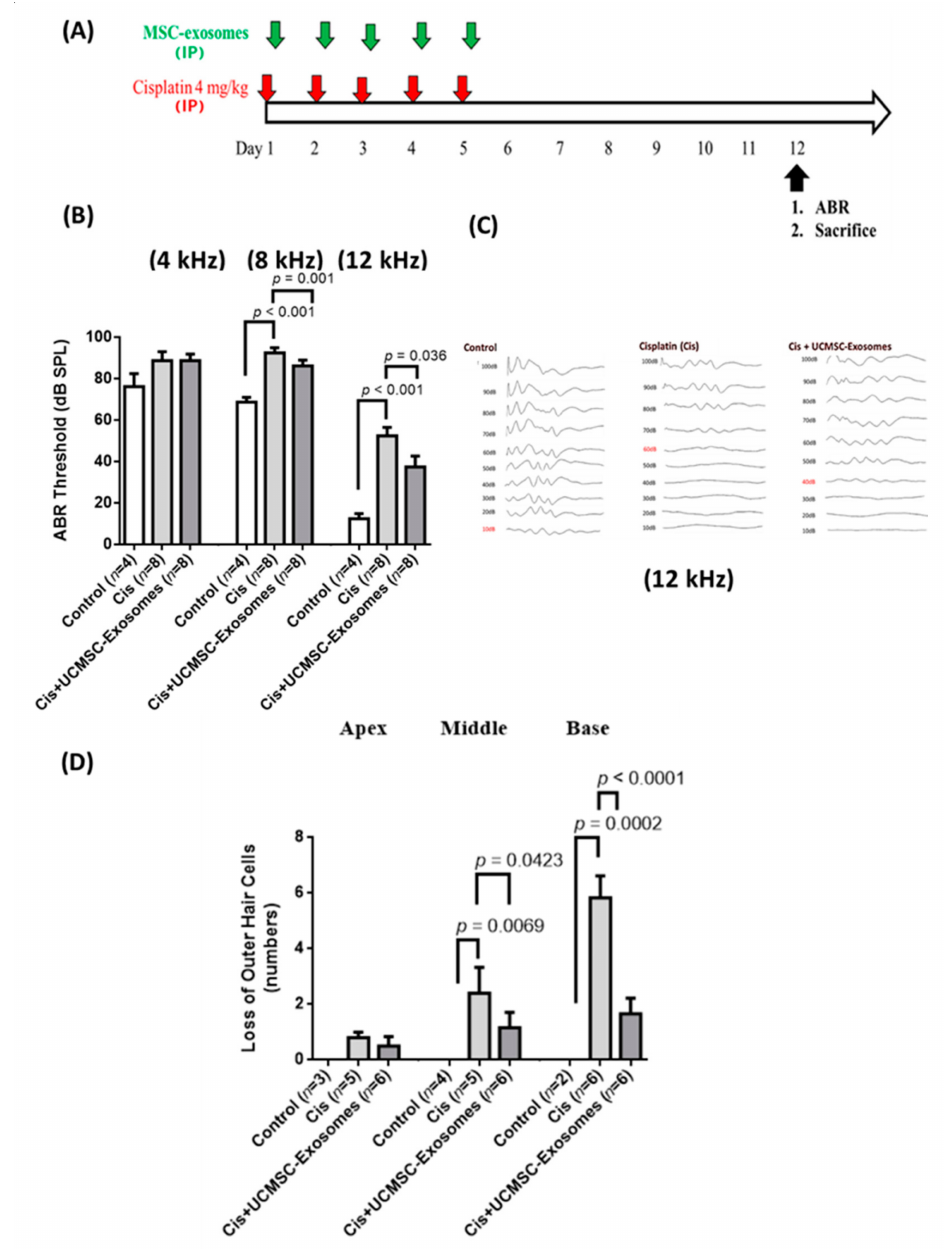
Figure 2. Effects of intraperitoneal injection of umbilical cord mesenchymal stromal cell (UCMSC) exosomes on cisplatin-induced hearing loss in mice. ( A ) Schematic of the experimental design of chronic administration of cisplatin in mice with induced hearing loss. Cisplatin (4 mg/kg) was injected intraperitoneally once per day for 5 consecutive days. UCMSC exosomes (1.2 µ g/ µ L) in 100 µ L of medium were administered intraperitoneally the same day after cisplatin injection. After 7 days, the hearing thresholds of all groups of mice were measured using an auditory brain response (ABR) instrument. Next, the mice were sacrificed to collect cochlear tissue for immunohistochemical staining. ( B ) ABR measurements revealed that UCMSC-exosome treatment significantly reduced the hearing thresholds at 8 and 12 kHz in the cisplatin-injected mice n = 4–8 per group. ( C ) The representative results of ABR at 12 kHz in each group of mice are shown. ( D ) Cisplatin-injected mice had significant loss of OHCs at the middle and basal regions compared with the control group. After UCMSC-exosome treatment in cisplatin-injected mice, the loss of OHCs at the middle and basal regions was significantly reduced compared with cisplatin-injected mice, n = 2–6 per group. Statistical significance was defined as p <